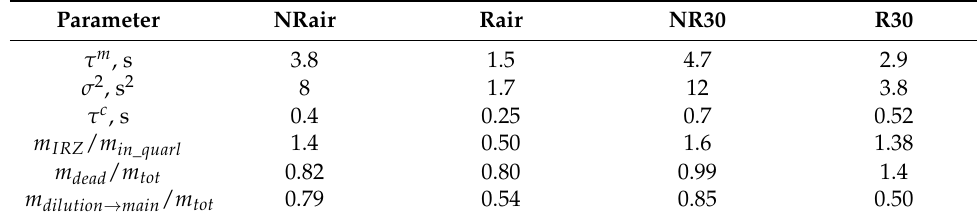
Table 6. Non-reactive and reactive